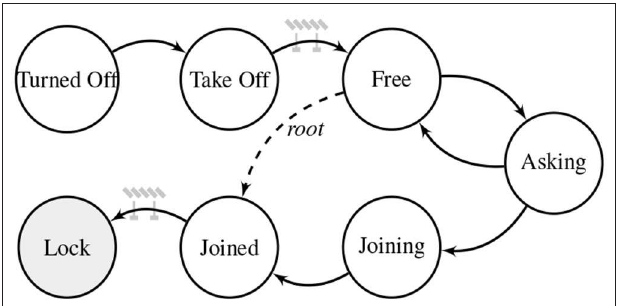
FIGURE 5 | The behavior law of the progressive task allocation algorithm represented as a finite state machine. Every robot joining the mission will experience states TurnedOff , TakeOff , Free , Asking , Joining and Joined . Before switching to state Free , and Lock the robots wait for consensus in a transition barrier